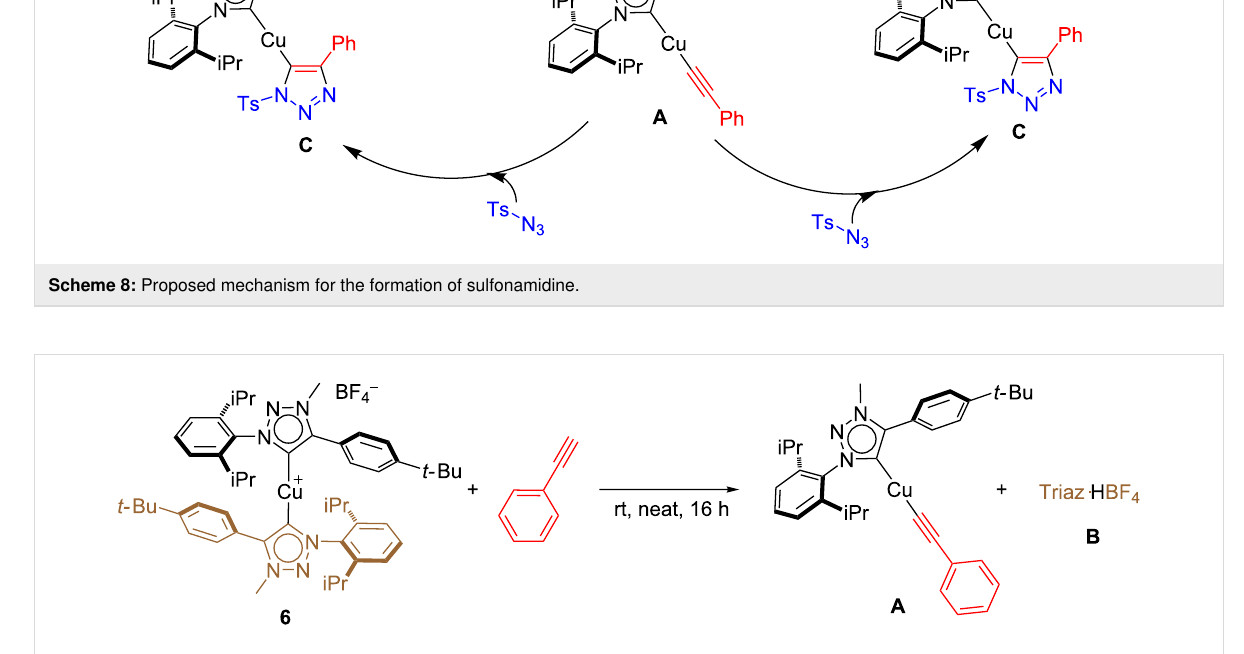
Scheme 9: Stoichiometric reaction between 6 and 8